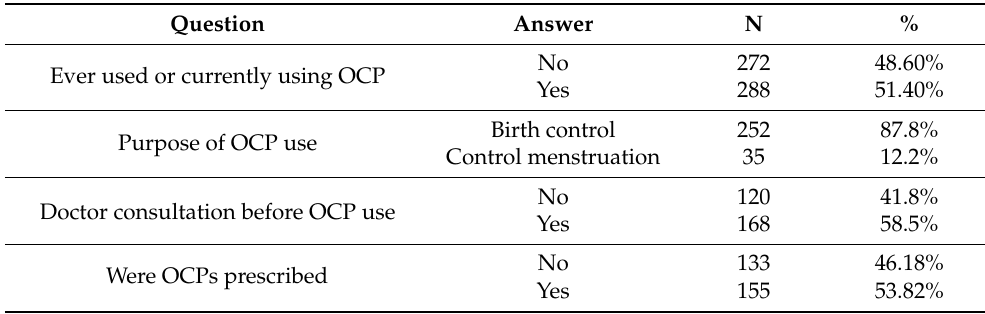
Table 2. Pattern of OCP usage.